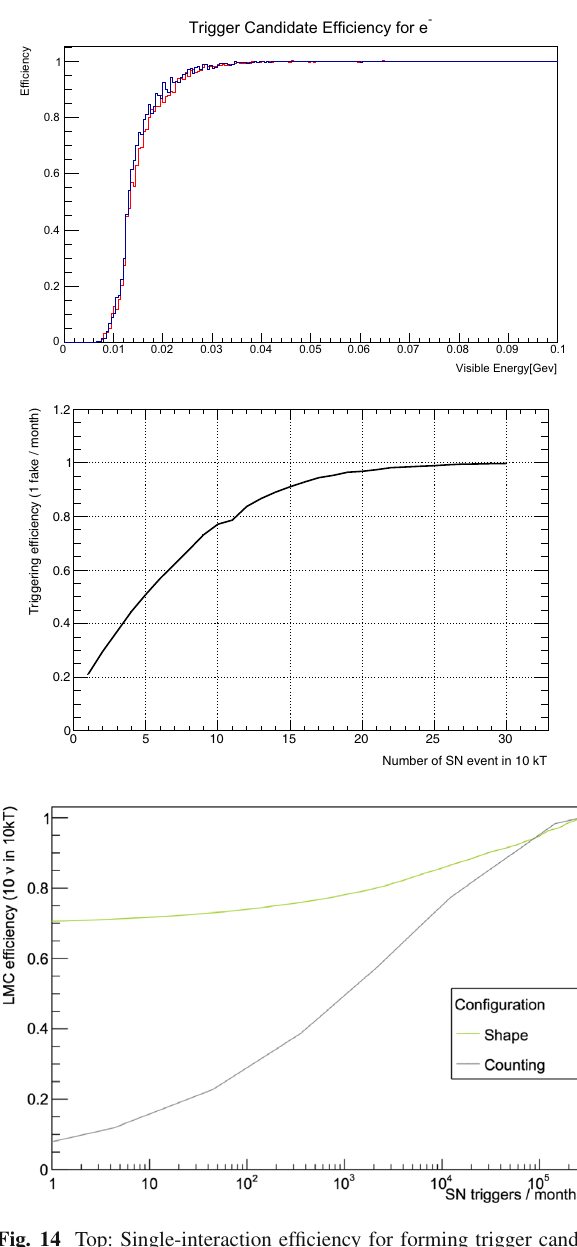
Fig. 14 Top: Single-interaction efficiency for forming trigger candi- dates from trigger primitives generated online (in blue) and offline (in red), using SP TPC information, as a function of visible energy for electrons such as those from low-energy ν e CC scattering on argon. Middle: Supernova burst trigger efficiency as a function of the number of supernova neutrino interactions expected in a 10-kton SP module, for a likelihood trigger approach that utilizes sum digitized-charge shape information of trigger candidates input into the trigger decision. Bot- tom: Supernova burst trigger efficiency as a function of total (signal and fake) trigger bursts per month, for a supernova burst at the Large Magellanic Cloud, where about 10 neutrino interactions are expected in a 10 kton module (see Fig. 12). The efficiency gain with an energy- weighted scheme over a counting-only trigger is significantly